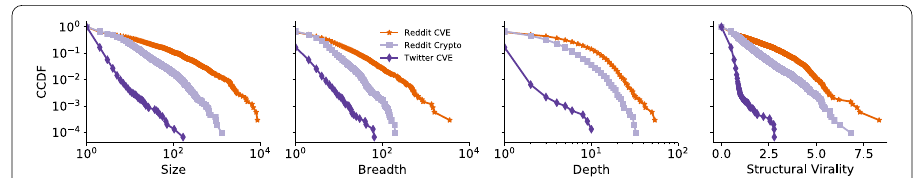
Fig. 3 Complementary Cumulative Distributions (CCDF) of cascade size, breadth, depth, and structural virality within each dataset